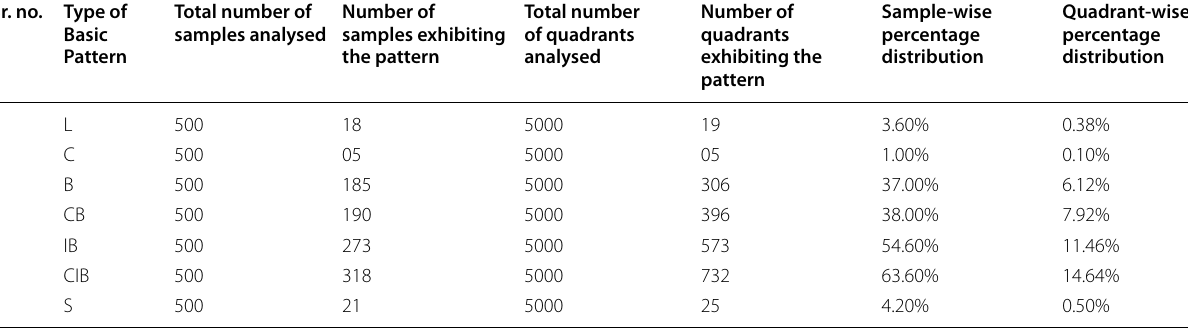
Table 4 Frequency of Basic